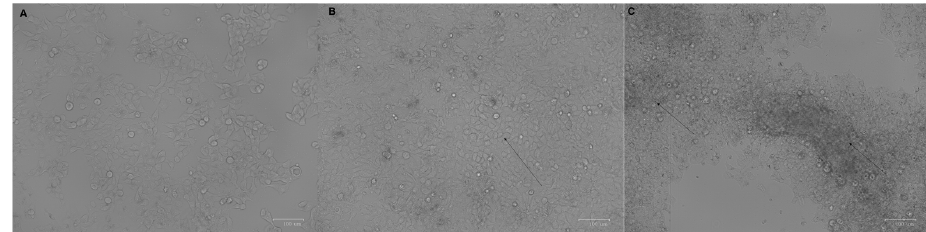
Figure 1. Morphological changes accompanied tamoxifen resistance development; ( A ) untreated control MCF-7 cells, ( B ) MCF-7 cells treated with 30 µM tamoxifen and ( C ) MCF-7 cells treated with 40 µM tamoxifen. Arrows indicate the change in cell shape in comparison to the epithelial-like shape of MCF-7 cells. Images were taken using ZOE Fluorescent Cell Imager (Bio-Rad, Hercules, CA USA) (scale bar 100 µm). Experiments were repeated at 3 different times.